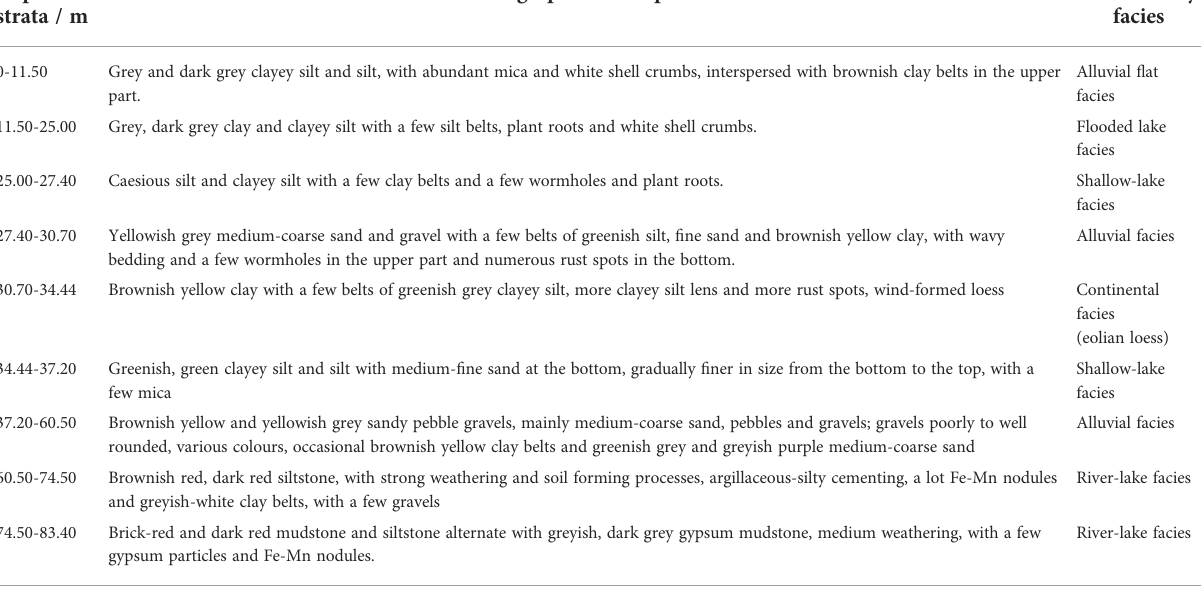
TABLE 3 The stratigraphic description and sedimentary facies of the FC borehole in